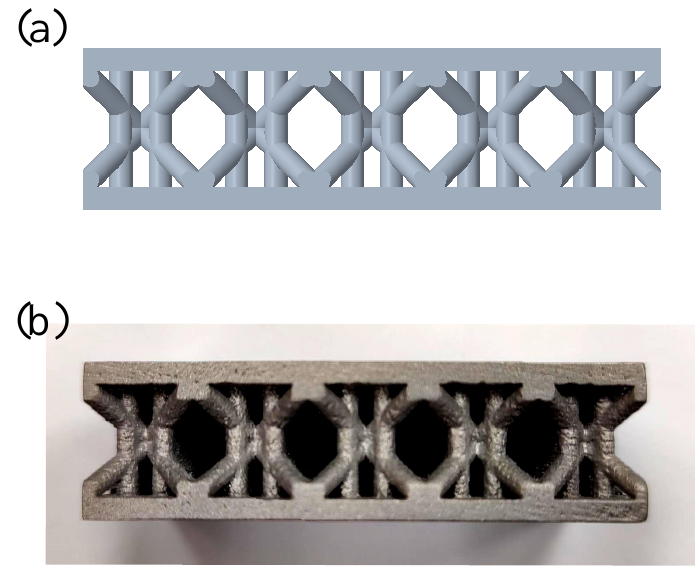
Figure 7. The specimen manufactured by SLM. ( a ) CAD model of the specimen; ( b ) the BCC4IZ